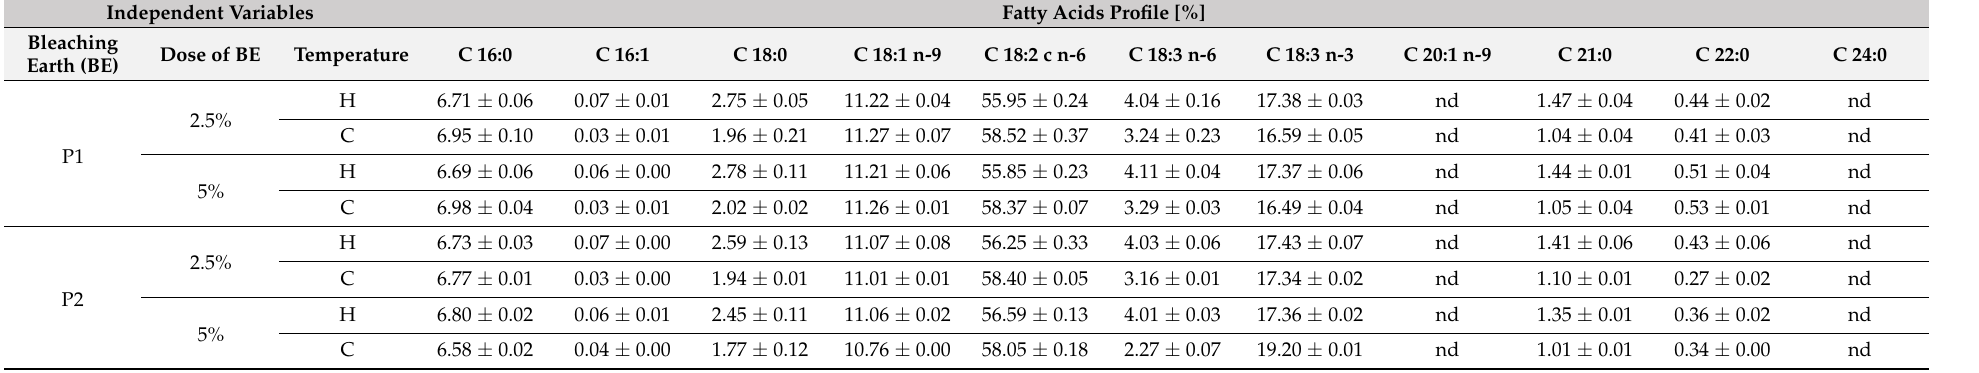
Table A3. Fatty acids profile of bleaching hemp oil from the ‘Finola’